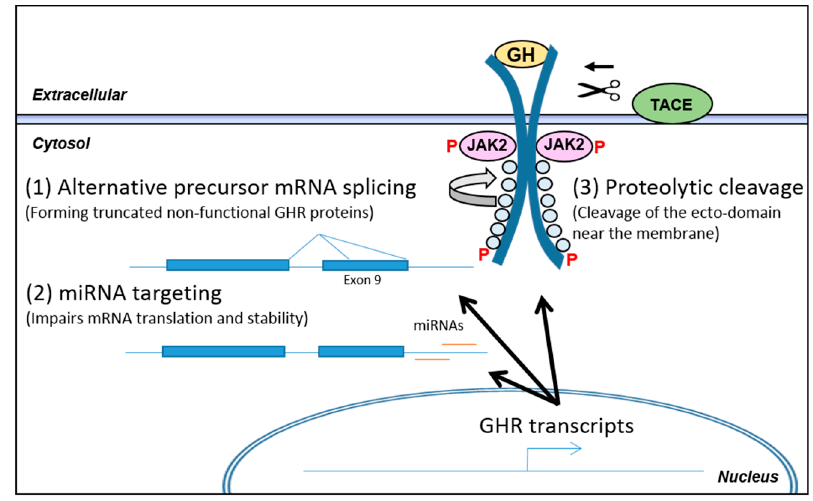
Figure 4. Post-transcriptional regulation of GHR. Following transcription of the GHR gene, the fate of the resulting pre-mRNA/mRNA/protein is influenced by different processes which impact the functionality of the resulting protein product. The 3 arrows indicate the possible post-transcriptional modifications limiting functionality of the mature GHR protein ( 1 ) Alternative splicing of the pre-mRNA has been described, where exon 9 is partly or fully being skipped. This introduces premature stop codons, leading to formation of truncated GHR proteins lacking the entire intracellular domain. This renders the receptor functionally dominant negative when the truncated variants complexes with full length variants. Regulation of this alternative splicing is still incompletely understood; ( 2 ) Sparse reports have evaluated miRNA targeting of the GHR mRNA and identified miRNA (miR)-129-5p, miR-142-3p, miR-202, and miR-16 to target GHR in cell lines. The regulation and the significance of miRNAs in GHR regulation is still unknown; ( 3 ) TNF- α -converting enzyme (TACE) is upregulated during inflammation and functions as a “sheddase” for TNF- α but does also target the GHR protein. Cleavage of the GHR ecto-domain (indicated by scissor and arrow) disrupts GHR function and releases the ecto-domain as GH binding protein. TACE functions mainly in the secretory pathway but also on the cell membrane.